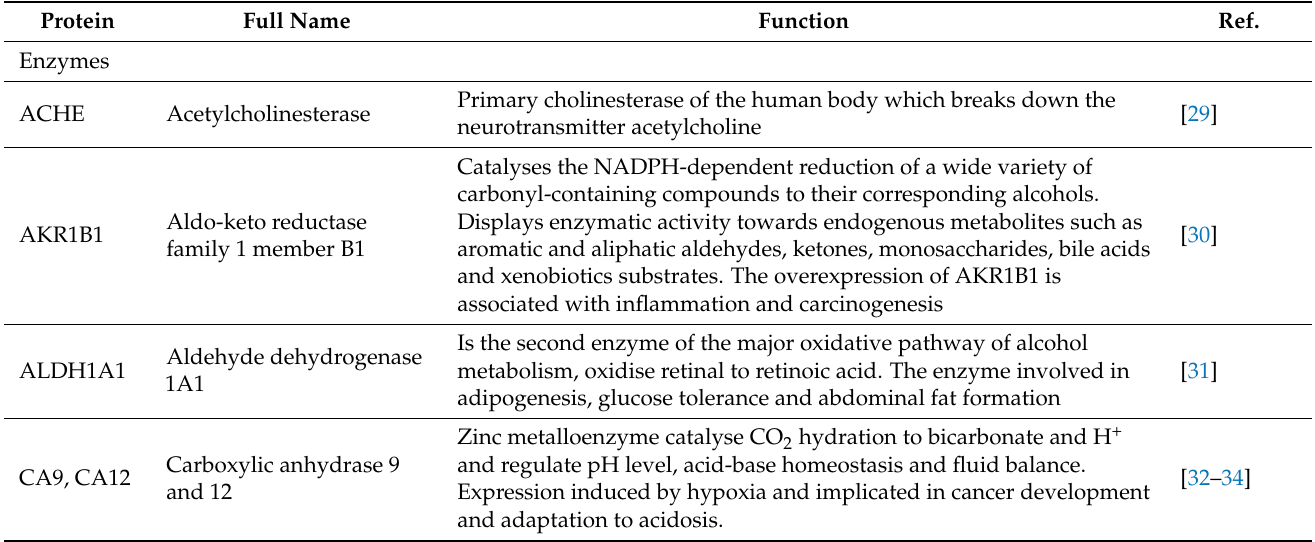
Figure 1. 4MU, 4MUG and 4MUS targets retrieved from PubChem BioAssay database. ( A )—target counts in Active and Inconclusive data sets with respect to target function and 4MU derivative. ( B )— Venn diagram with Active and Inconclusive sets intersection. ( C )—List of Active targets, ( D )—list of Inconclusive targets. Common targets for Active and Inconclusive sets are shown in blue, and EWS/FLI protein, which was excluded from further analysis, is shown in red. Table 1. Function of the acquired 4MU target